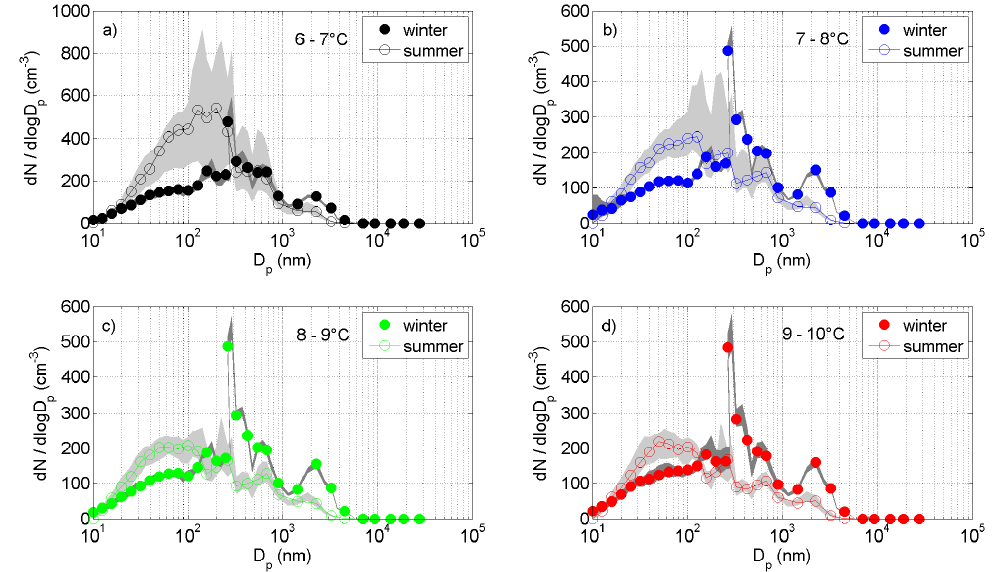
Fig. 5. Comparison of particle number size distributions resulting from water sampled close to the fjord mouth during summertime and wintertime, for the same water temperature ranges of (a) 6–7 ◦ C, (b) 7–8 ◦ C, (c) 8–9 ◦ C and (d) 9–10 ◦ C. For clarity only every second data point is shown. Grey shaded areas represent the interquartile ranges. Note the different scale for the lowest temperature range.